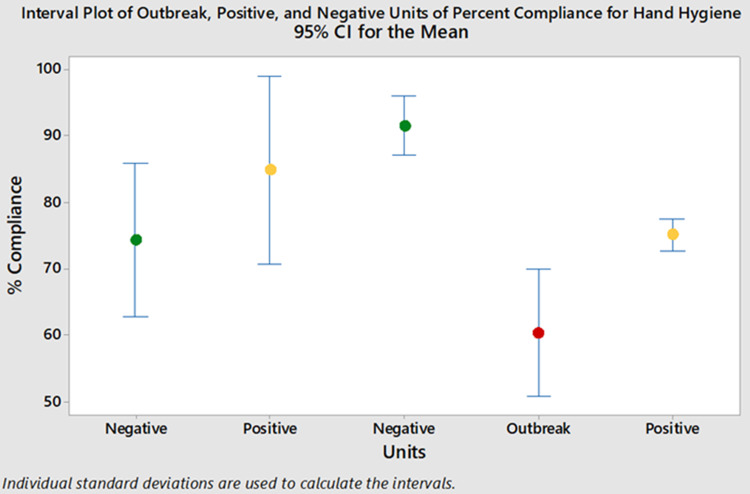
Mean monthly hand hygiene compliance. Note. Green, negative control wards; yellow, positive control wards; red, outbreak ward.